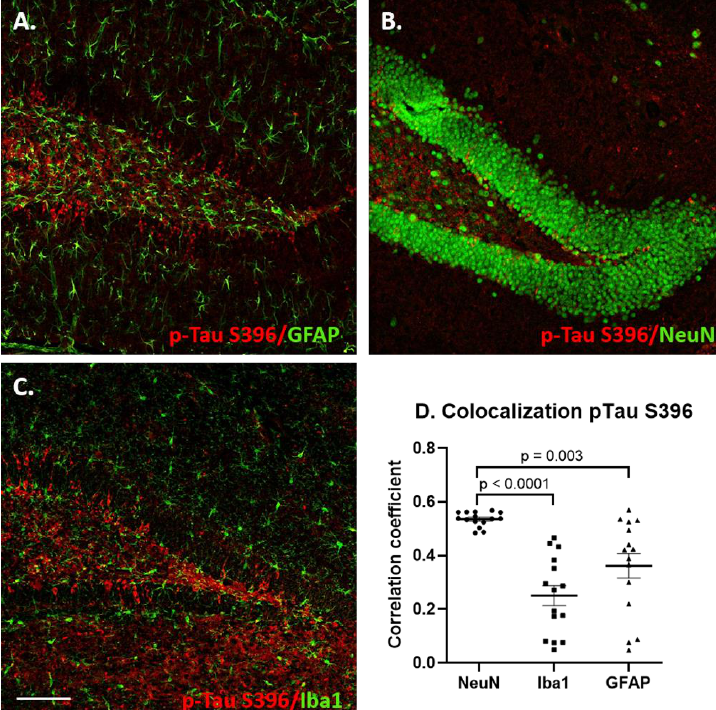
Figure 9. Co-localization of p-Tau S396 staining with neuronal and glial markers in the dentate gyrus region of hippocampus 1 month following DS-AD NDEV injections. ( A ) Double labeling for p-Tau S396 (red) and GFAP (green), ( B ) double labeling for p-Tau S396 (red) and NeuN (green), ( C ) double labeling for p-Tau S396 (red) and Iba1 (green). Scale bar in C corresponds to 100 microns. The scatter plot graph ( D ) shows the correlation coefficients for p-Tau S396 with NeuN, Iba1 and